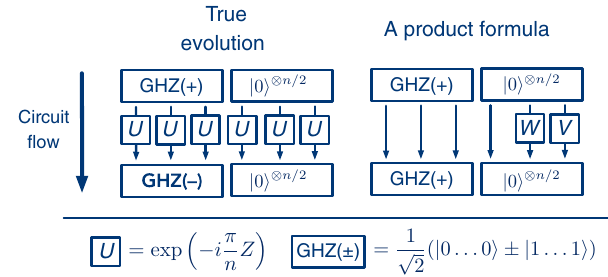
FIG. 4. Illustration of the worst-case input for a product for- mula simulating evolution of a simple Hamiltonian. The Hamil- (cid:2) n tonian H = 1 / n Z k produces a time evolution that factor- k = 1 izes into single qubit unitaries U (left). A product formula with fewer than n / 2 single-site terms (right) is too small to address all qubits; at least n / 2 of them must remain untouched. These errors accumulate for a GHZ state comprised of these untouched qubits.